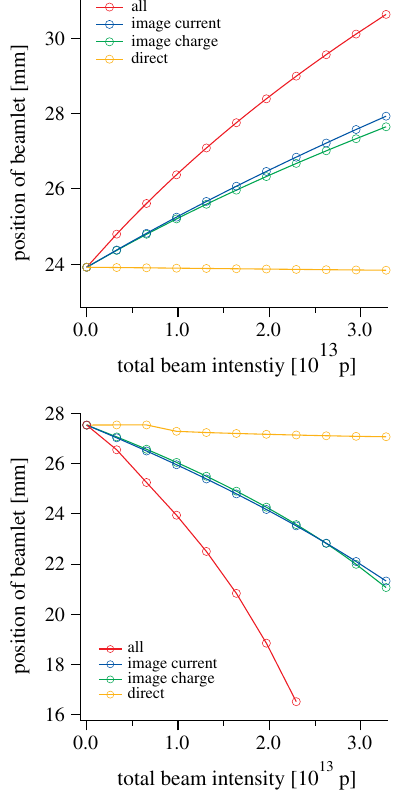
FIG. 8. Beamlet position as a function of the total beam intensity. The cases corresponding to h 2 ¼ 6 . 245 are shown in the upper and lower plot, h 2 > 0 ; Q ; 0 x respectively. The contribution of the various sources of intensity- dependent position shifts is indicated by the various curves. Parallel plate electric boundary conditions are included. The beam momentum is 14 GeV =c